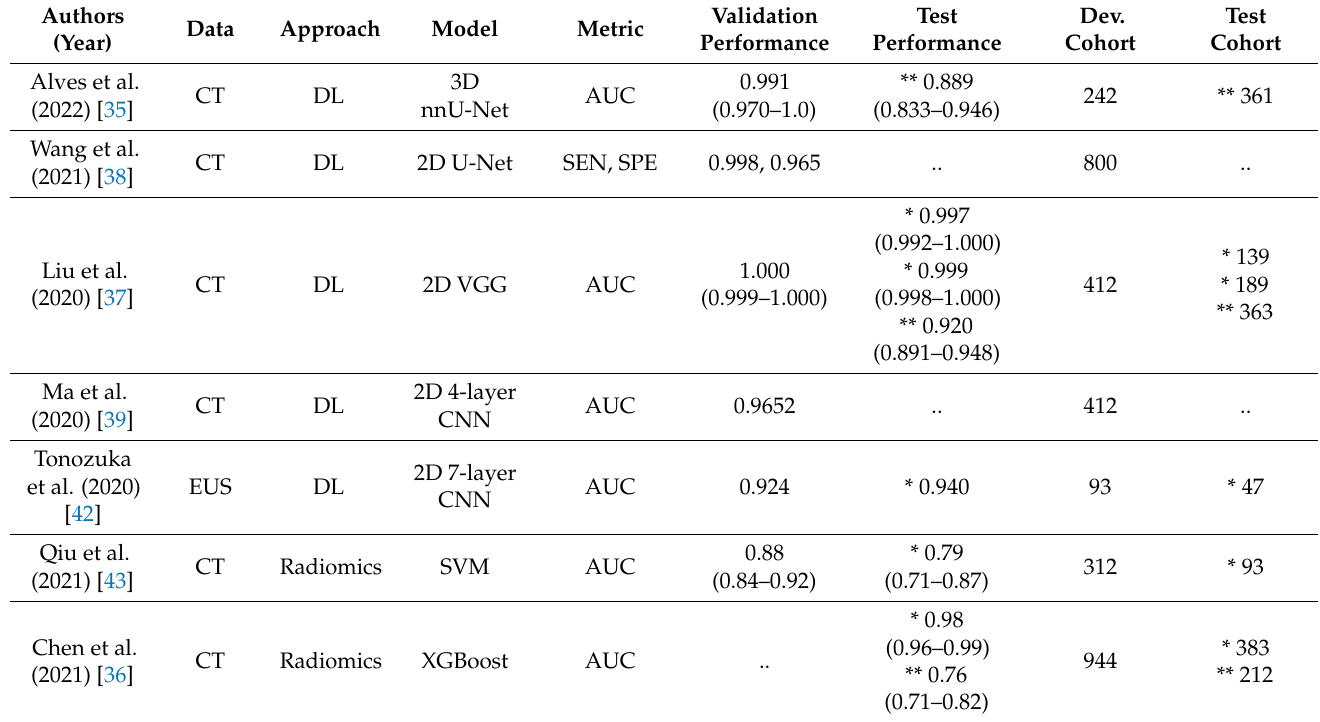
Table 1. Summary of papers on AI for PDAC detection. The performance for the validation and test sets is reported with respective 95% Confidence Interval or standard deviation when it was pro- vided.